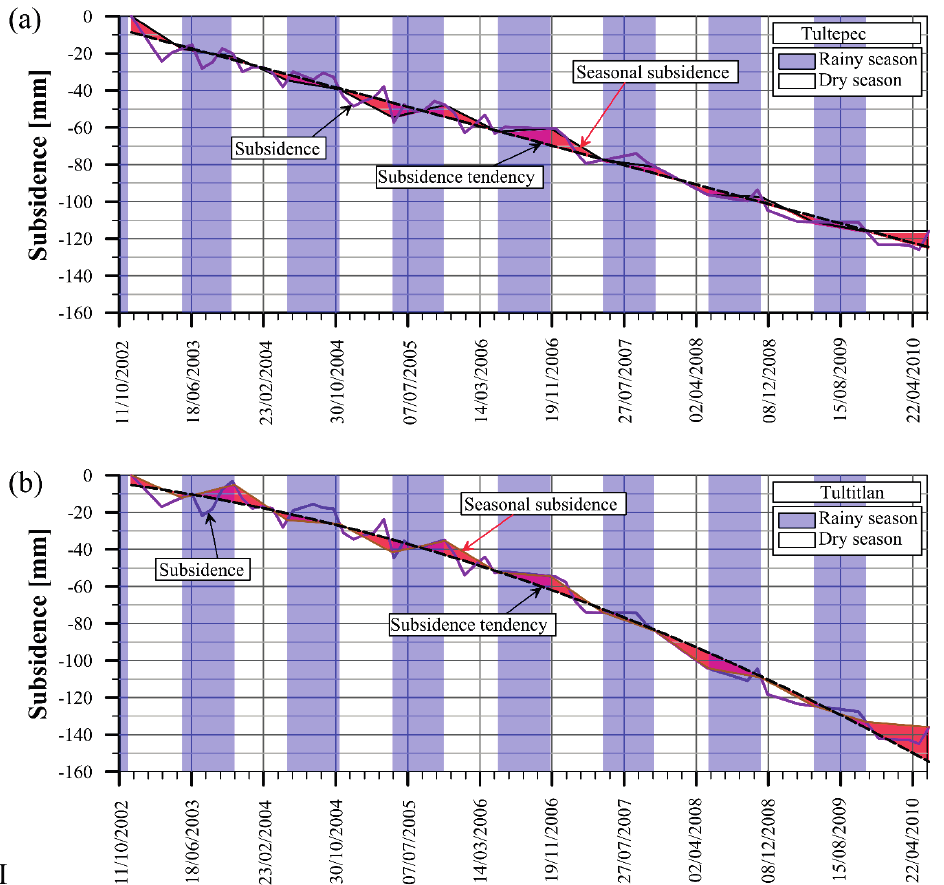
Figure 7. Seasonal time series analysis. The wet and rainy seasons are distinguished in white and blue, respectively. The coloured red area correspond to the area defined from the “seasonal tendency” (light brown line) and the global subsidence trend (dashed black line) of the data (violet